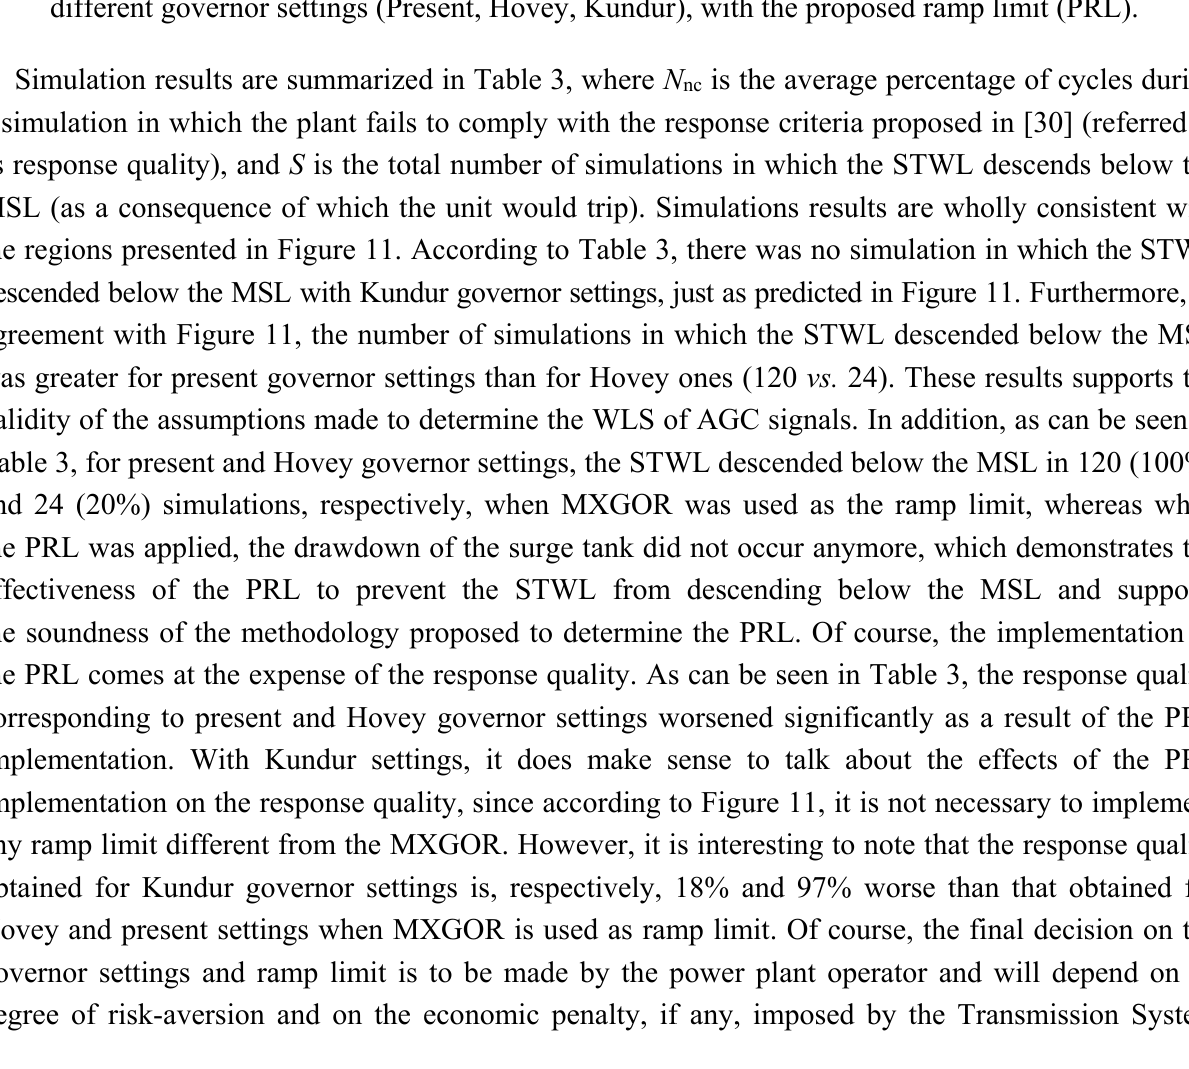
Figure 14. Output power and surge tank water level in response to an AGC signal for different governor settings (Present, Hovey, Kundur), with the proposed ramp limit